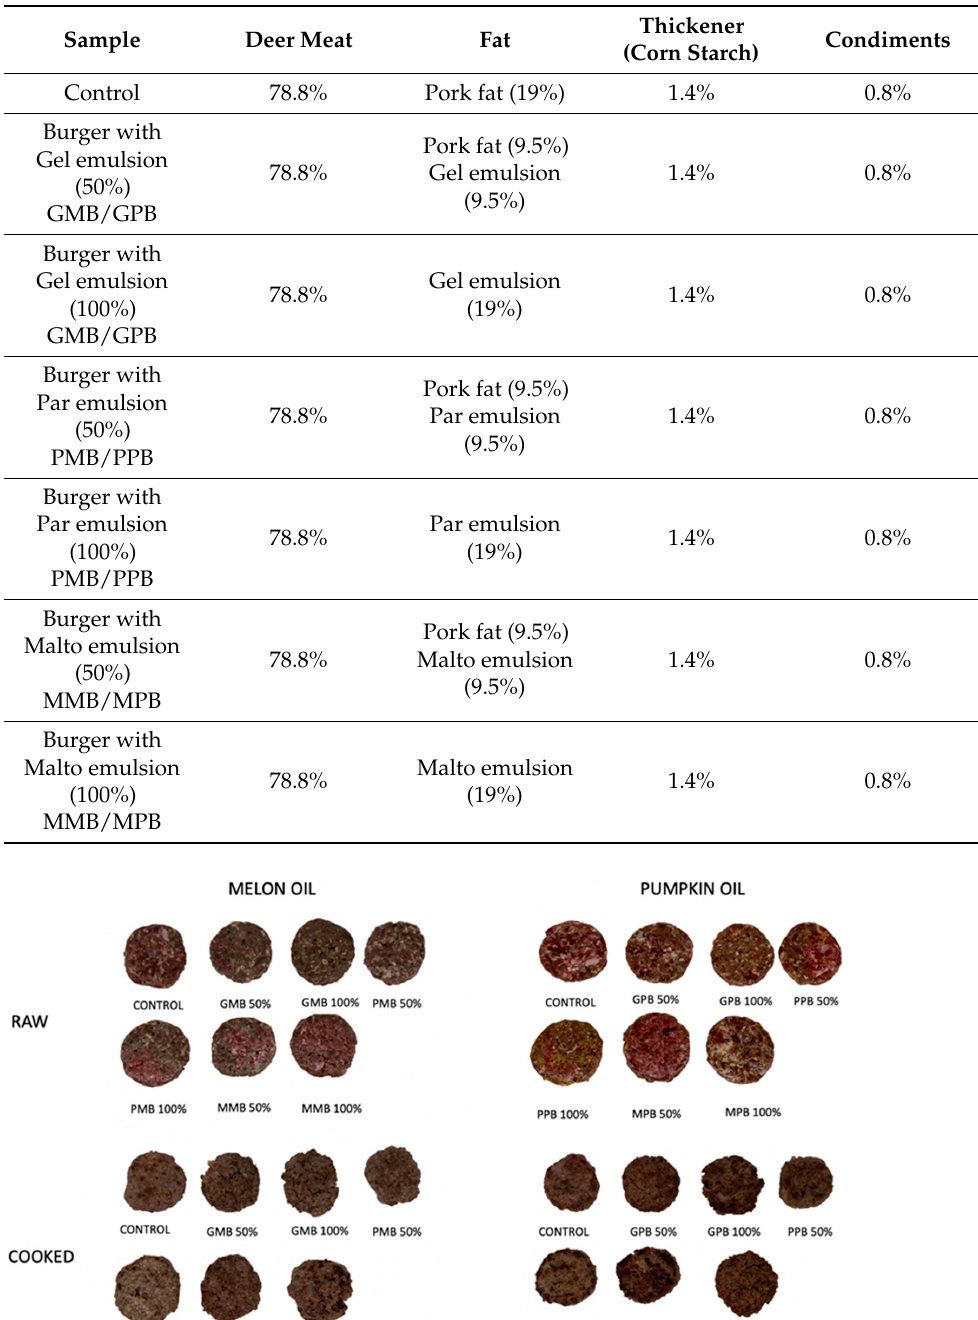
Table 2. Formulation of the burgers elaborated with emulsified melon and pumpkin oil. GMB: Gel emulsion Melon Burger; GPB: Gel emulsion Pumpkin Burger; PMB: Par emulsion Melon Burger;